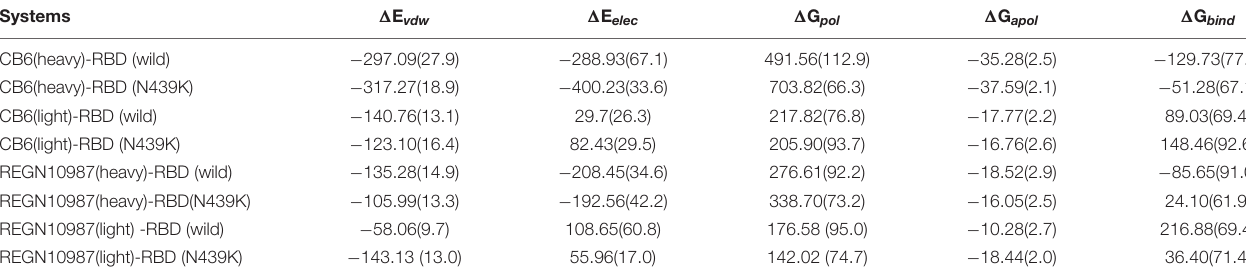
TABLE 2 | Energetic components of binding energy for SARS-CoV-2 RBD-mAbs complexes (kj/mol). Systems